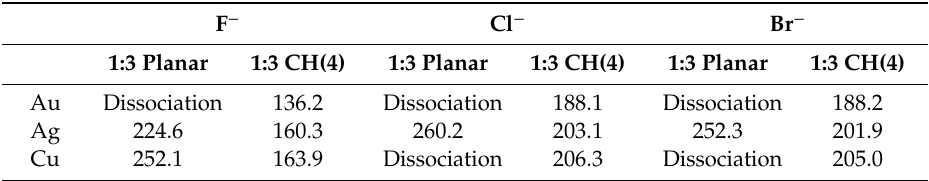
Table 5. Binding energies (kJ mol − 1 ) for the 1:3 planar and CH(4) complexes.